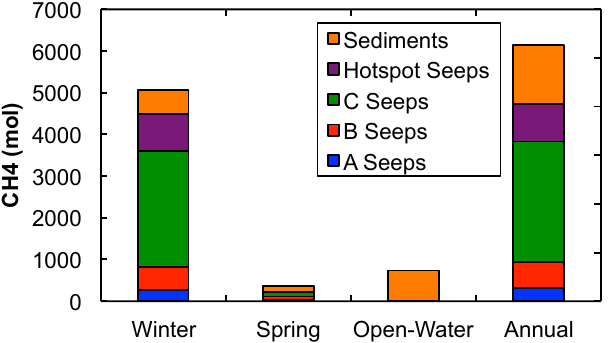
Figure 10. Seasonal and annual quantities of CH 4 dissolving into the water column from ebullition seeps and sediments in the base- line version of the model. Annually, 77% of dissolved CH 4 in Goldstream Lake originates from ebullition bubbles trapped be- neath winter ice, and 23% from CH 4 diffusion from bottom sed-